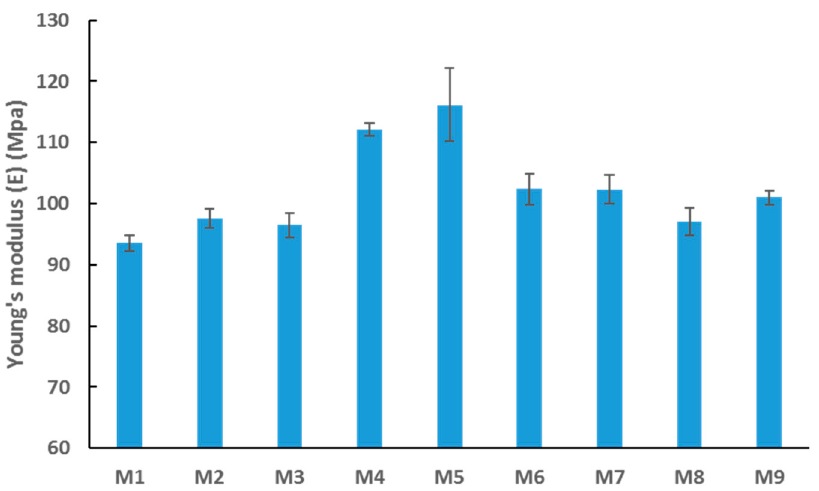
Figure 9. Average Young’s modulus values for synthesized PES membranes. Each bar represents the mean ± SD of three independent readings.